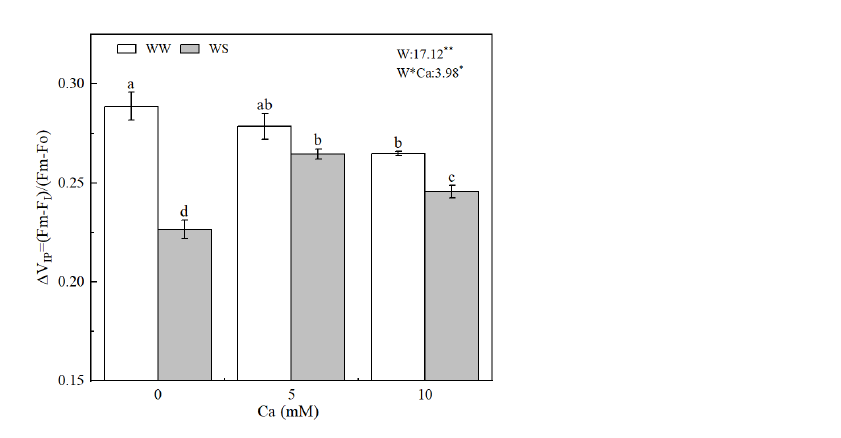
Figure 8. Effect of well water (WW), water stress (WS), and different calcium (Ca) on PI ABS (perfor- mance index, A ) and PI total (total performance index, B ). The capital letters indicated a significant difference at 0.05 among well water treatments. Moreover, the little letters indicated a significant difference at 0.05 among water stress treatments. The single * in the upper right corner indicated a